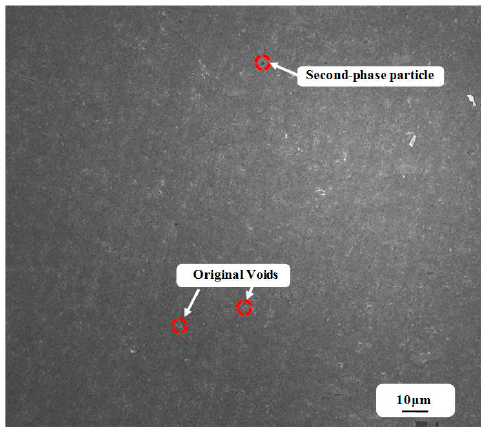
Figure 4. The initial void distribution in 5052-O aluminum alloy.